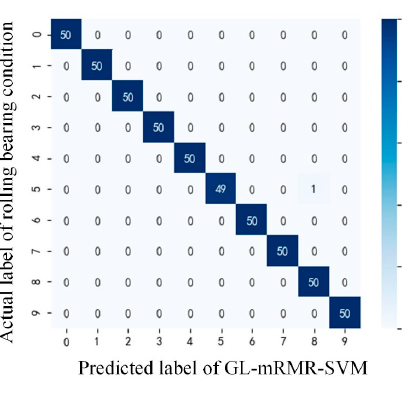
Figure 8. GL-mRMR-SVM results when k = 12.